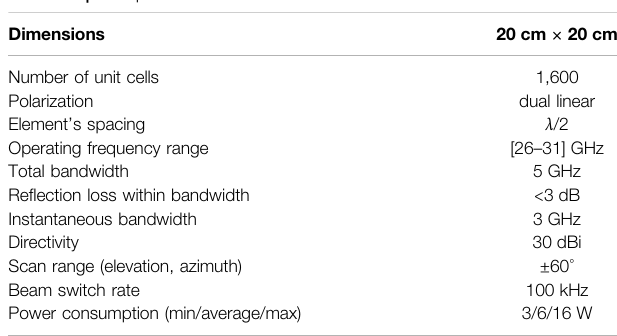
TABLE 1 | RIS speci fi cations